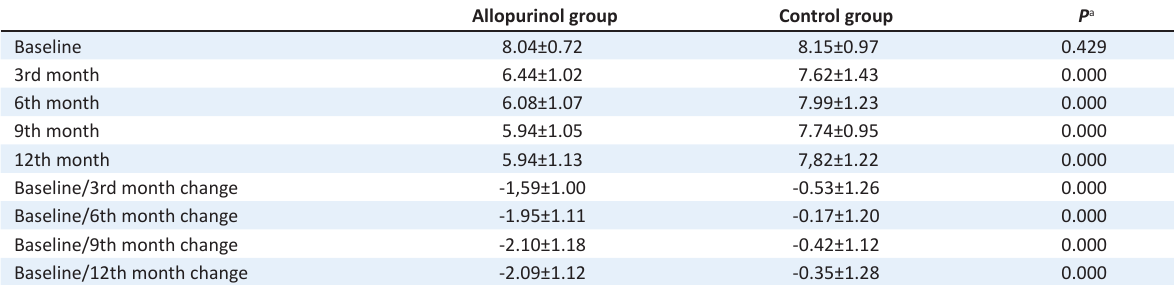
Table 3. The effect of allopurinol treatment on uric acid